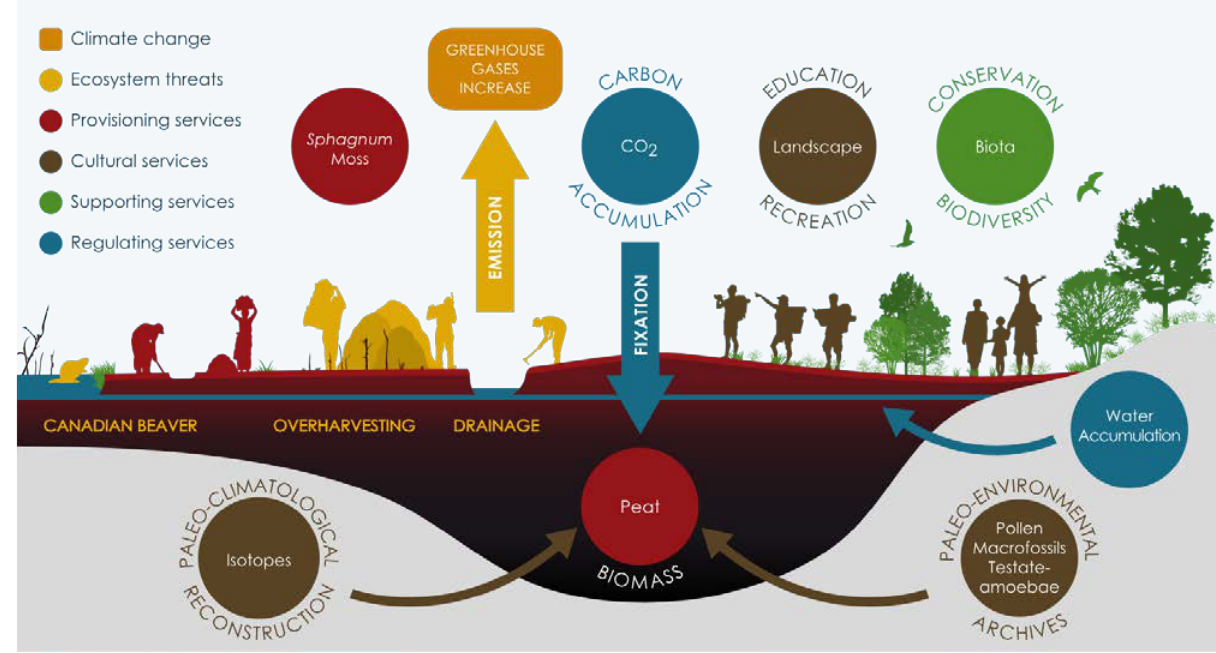
Figure 3. Ecosystem services and threats to peatlands of southern South